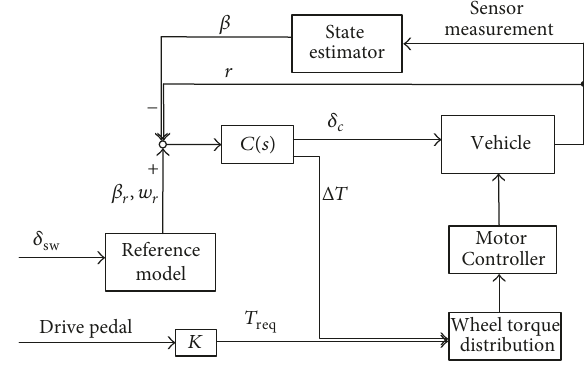
Figure 2: The diagram of the control